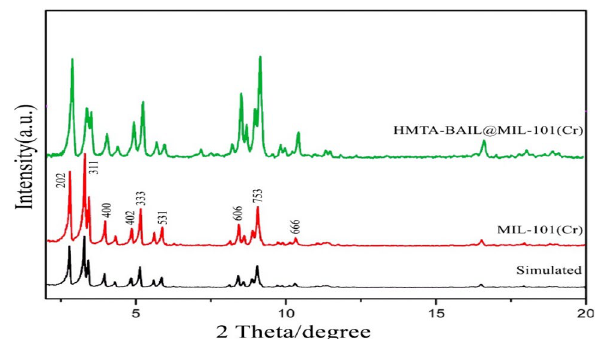
Figure 1. The XRD patterns of MIL-101(Cr) and